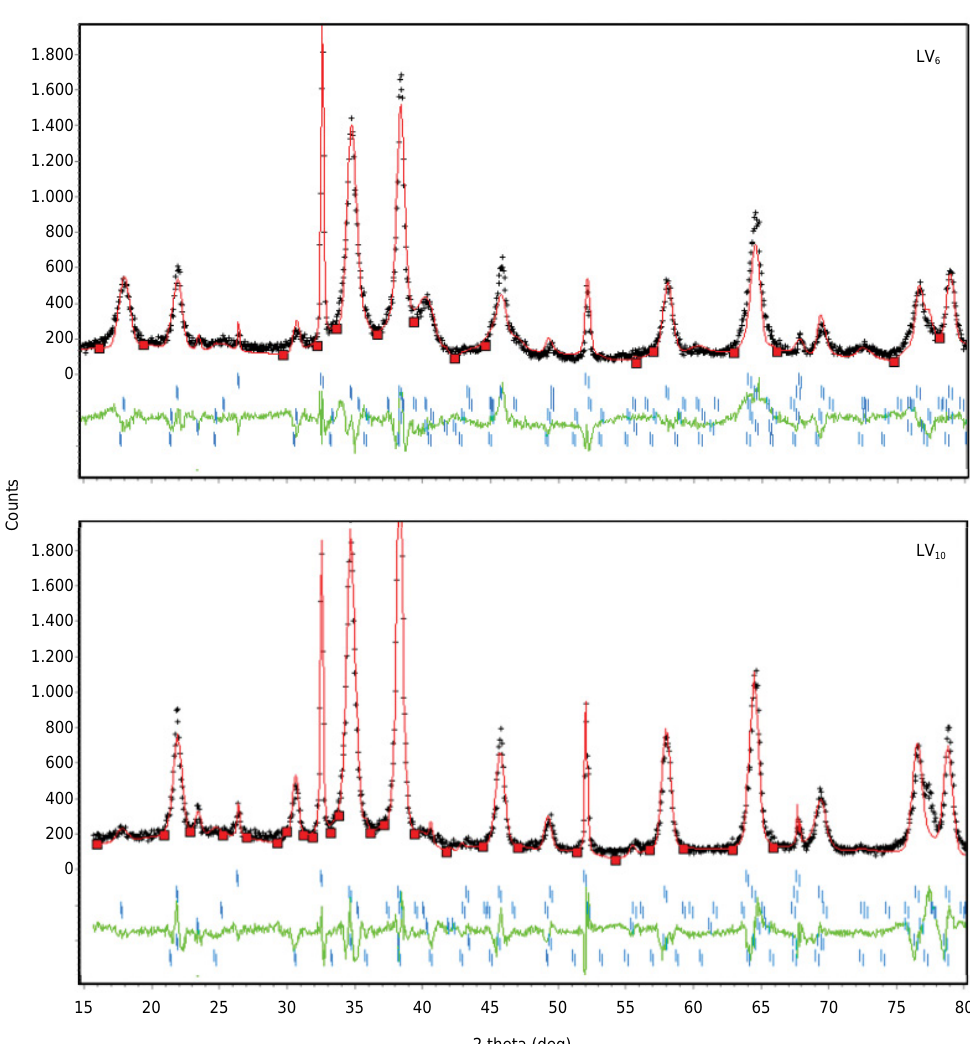
Figure 6. Selected X-ray pattern adjustments by Rietveld refinement method in the clay fraction after alkaline treatment with NaOH 5 mol L -1 . Soils LV 6 and LV 10 .